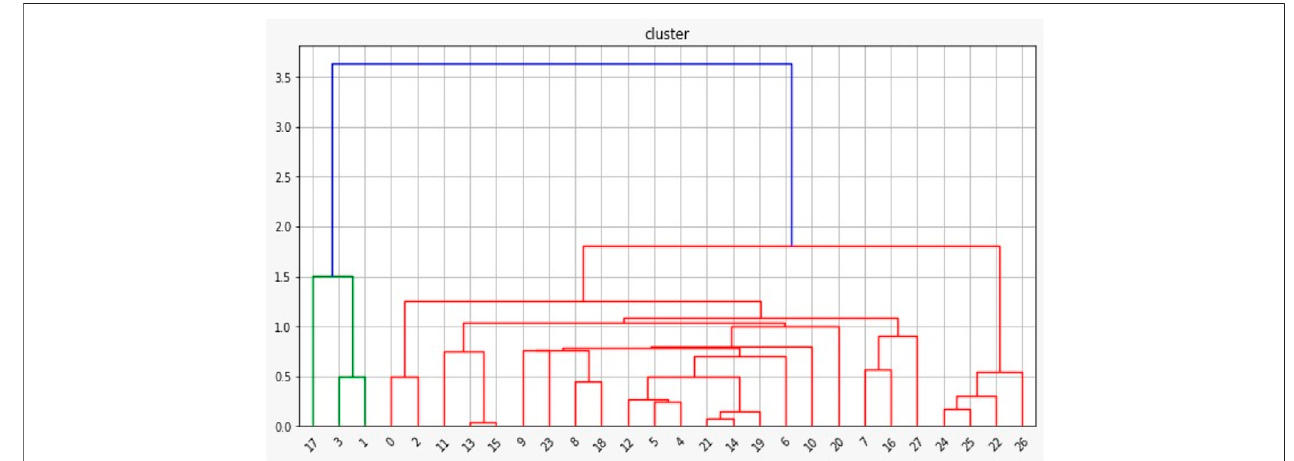
FIGURE 9 | Classi fi cation of 48 repetitive plans in the form of tree diagrams, Source: Author.